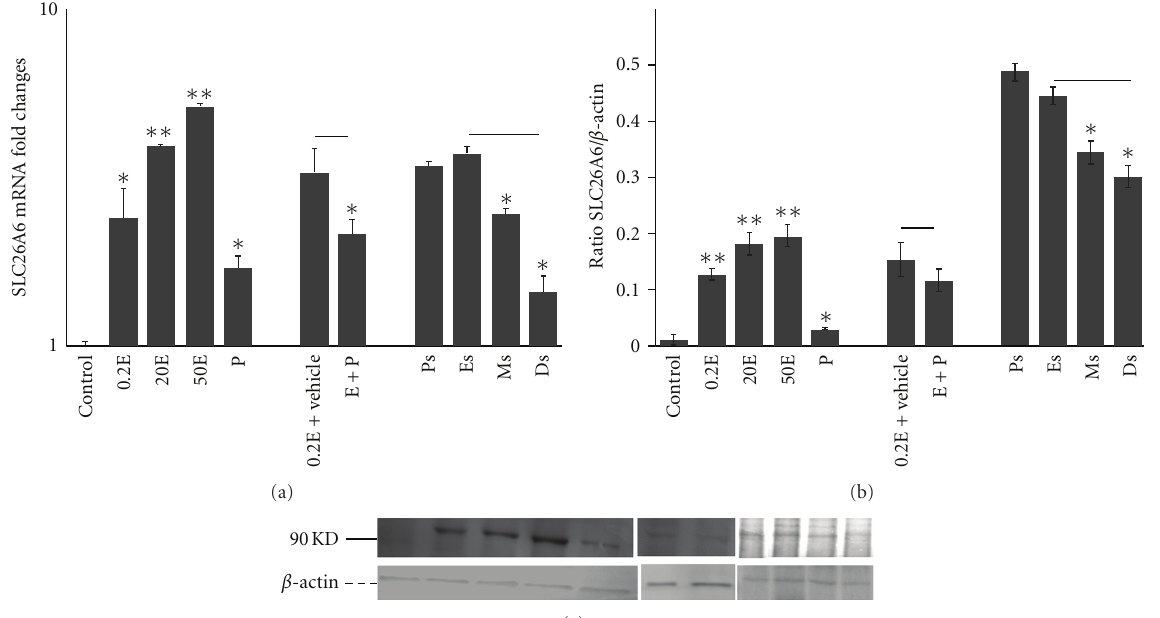
Figure 2: Real-time PCR quantitation (a), and Western blot analysis (b), and Western blot photo (c) of SLC26A6 in ovariectomized rats and rats at di ff erent stages of the oestrous cycle. SLC26A6 is from Cl − /HCO 3 − exchanger family that is upregulated by oestrogen and at Ps and Es stages of the oestrous cycle. Control: peanut oil., E: 0.2 μ g oestrogen, 20 E: 20 μ g oestrogen, 50 E: 50 μ g oestrogen, P: progesterone, E + vehicle: 0.2 μ g oestrogen + peanut oil E + P: 0.2 μ g oestrogen + progesterone. Ps: proestrus, Es: estrus, Ms: metestrus, Ds: diestrus: ∗ P < 0 . 05, ∗∗ P < 0 . 01, ∗∗∗ P < 0 .